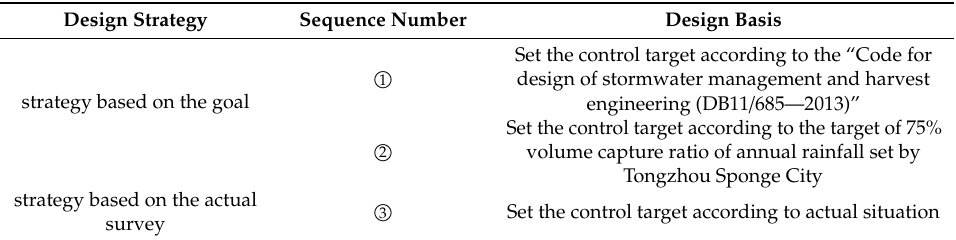
Table 2. Determination of low impact development (LID) construction strategy.